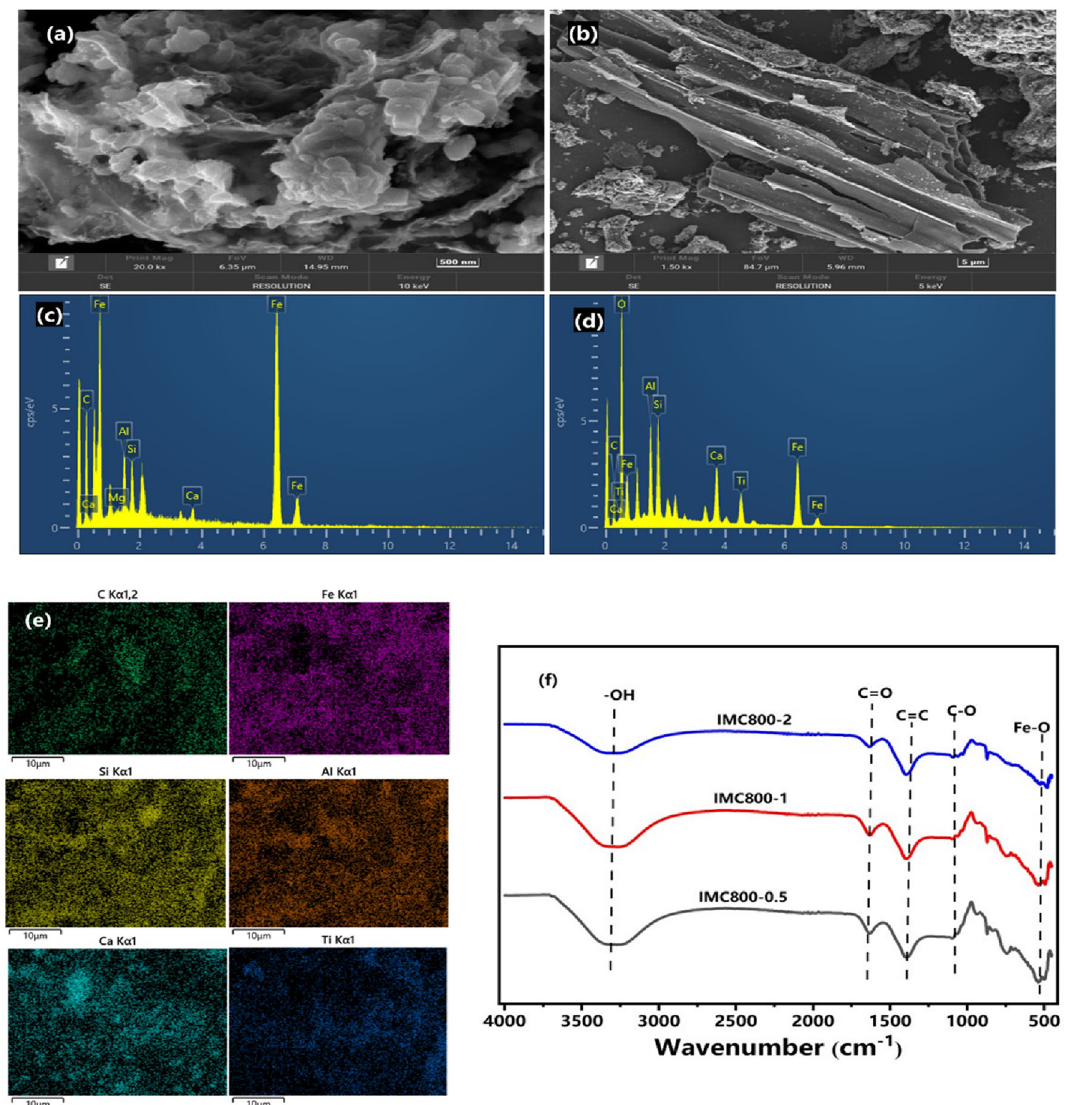
Figure 2. SEM–EDS analysis of IMC ( a – e ), Fourier transform infrared spectra (FT-IR) at different ratios of IMC800 ( f